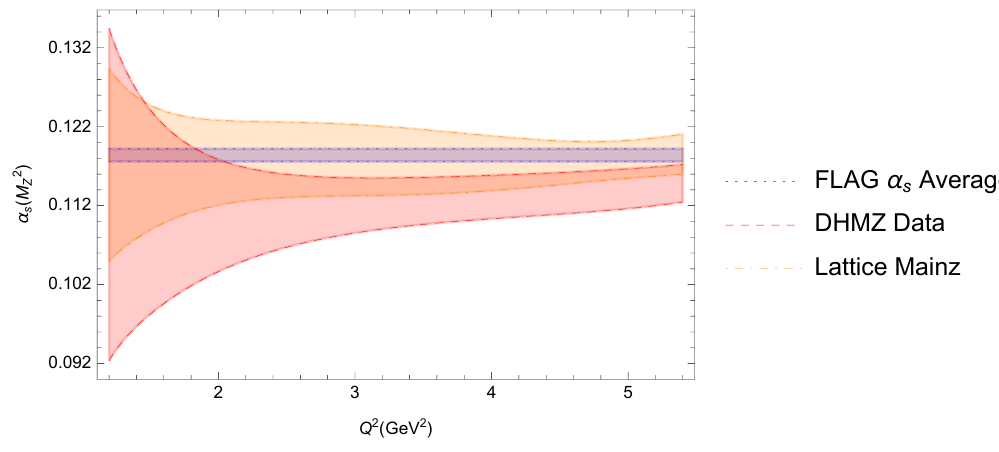
) = 0 . 1184 ± 0 . 0008 and Z